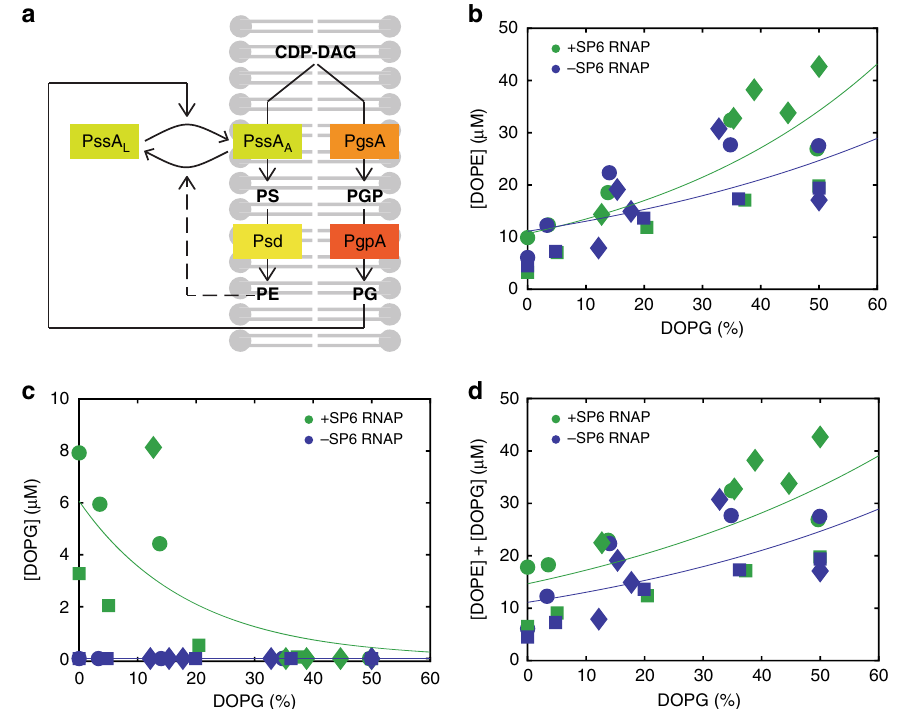
Fig. 2 Metabolic feedback as a regulator for cell-free synthesis of PE and PG. a Schematic illustration of PssA activity regulation by membrane content. PssA exists in the membrane-bound, activated state (PssA A ) and in the cytosolic, inactivated or latent state (PssA L ). High amounts of PG favour PssA A by promoting membrane recruitment, thus increasing the yield of synthesized PE. Low PG content (i.e. high fraction of PE) shifts the equilibrium to PssA L , channelling resources to the production of PG and reducing the fraction of synthesized PE. b – d Concentrations of synthesized PE ( b ), PG ( c ) and PE + PG ( d ) for different initial compositions of LUVs in the presence (green symbols) or absence (blue symbols) of SP6 RNAP. The three different markers represent data from three independent experiments. The solid lines are appended to guide the eye. Membranes always contain 50 mol% DOPC and varying fractions of DOPG and DOPE. Source data are available for ( b – d